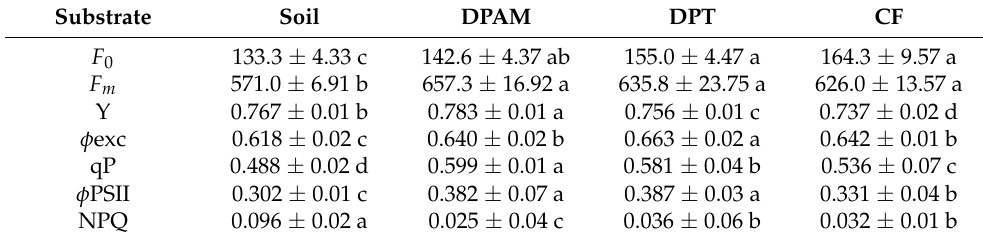
Table 2. Variation in the fluorescence parameters of tomato leaves grown on different